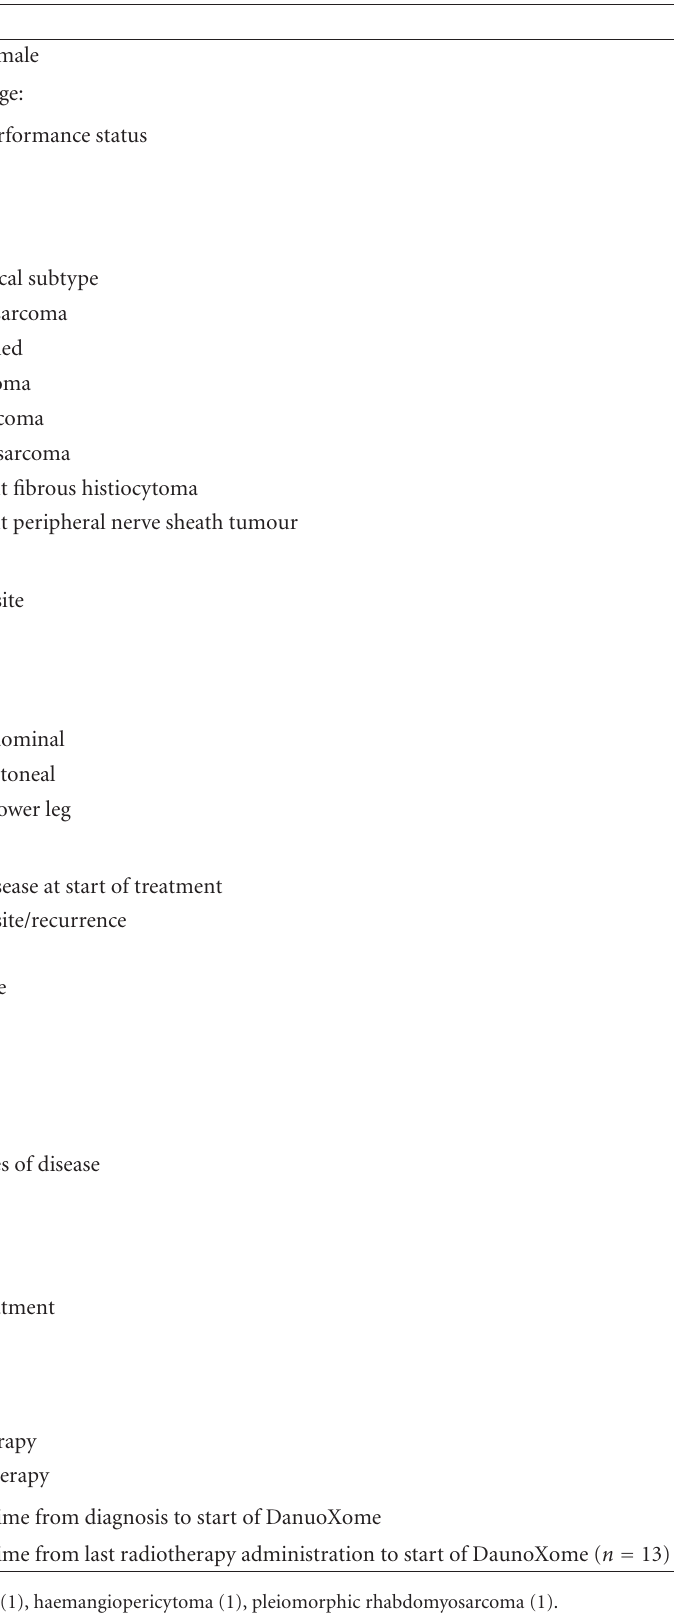
Table 1: Patient characteristics ( n =